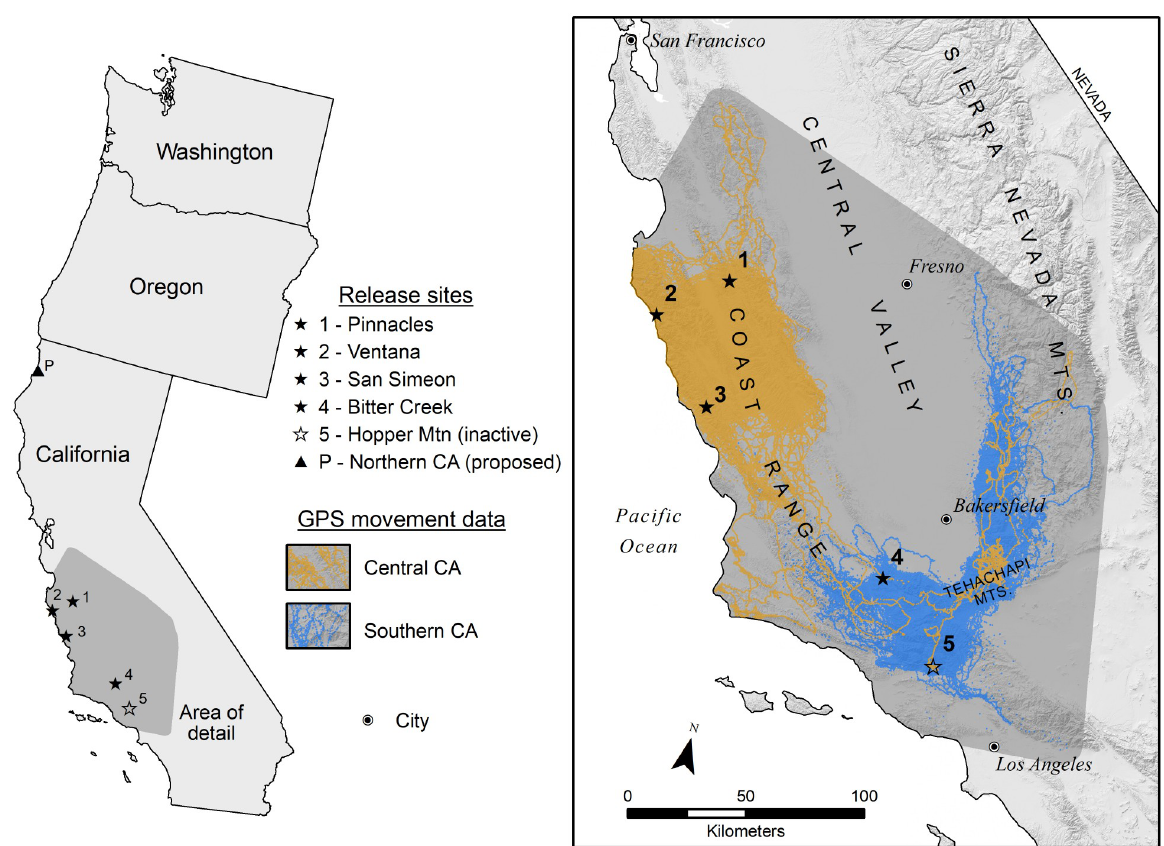
Fig 1. Study area, background area for developing a California condor landscape conductance surface (dark gray), in-flight California condor locations (July 2013-May 2017), and release sites.